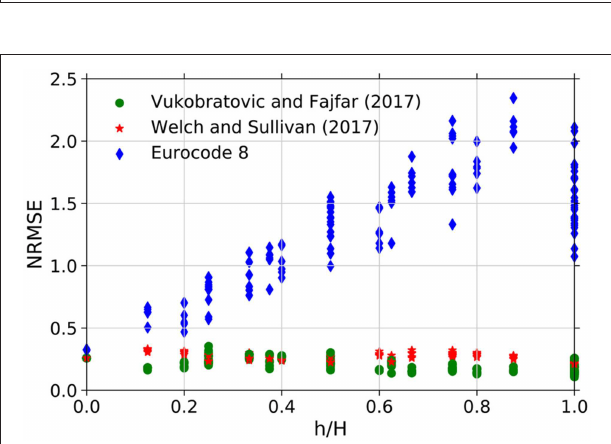
FIGURE 11 | Overview of PFA estimation accuracy assessment, with targeted inelastic ductility demands ( µ = 2) across all archetypes.